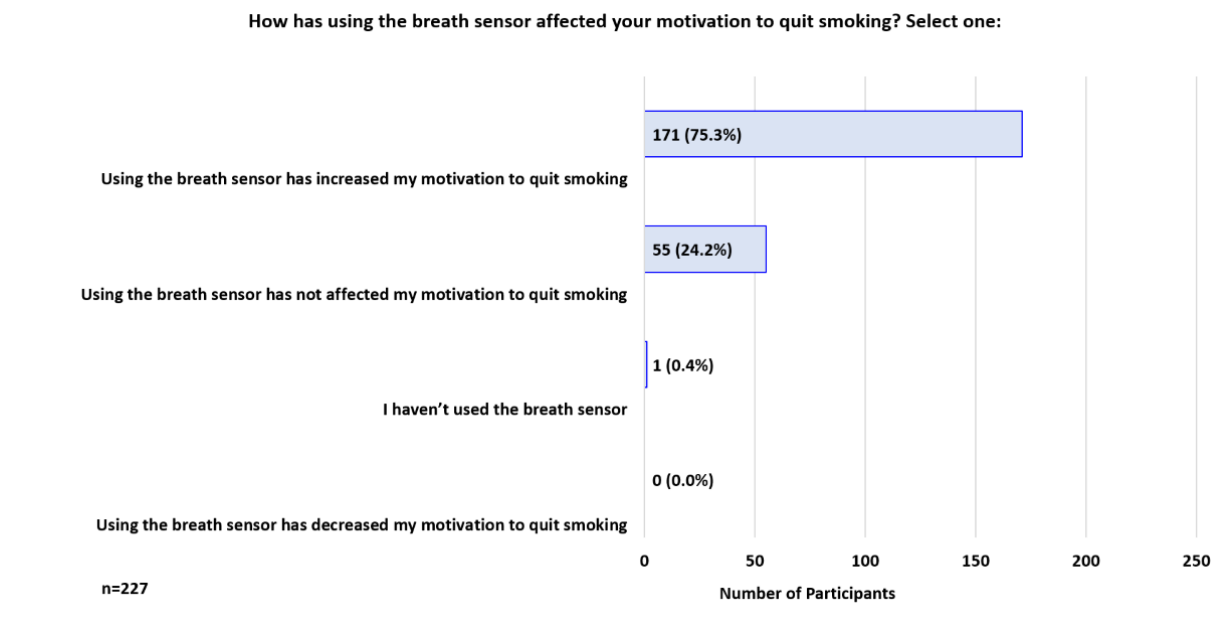
Figure 6. Participant Feedback: Effect of breath sensor on motivation to quit smoking (week 1).